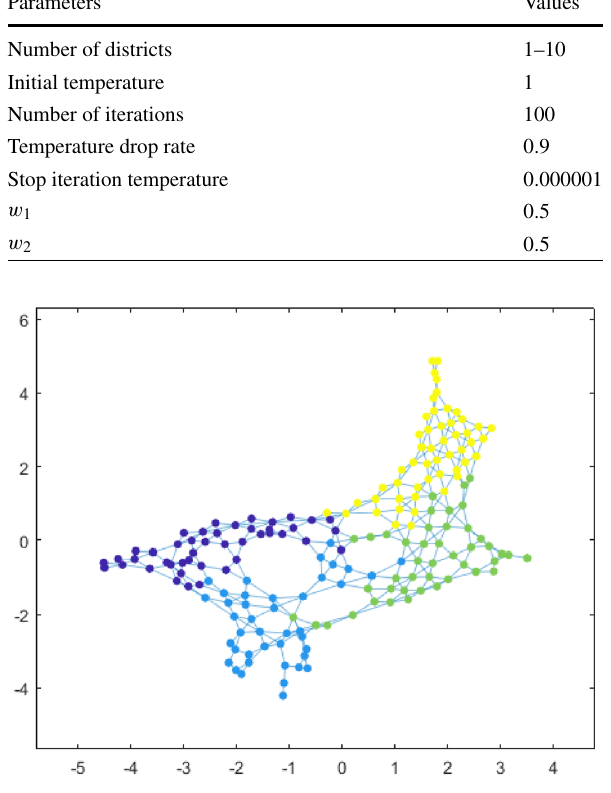
Fig. 1 Simulation result of small instance f 1